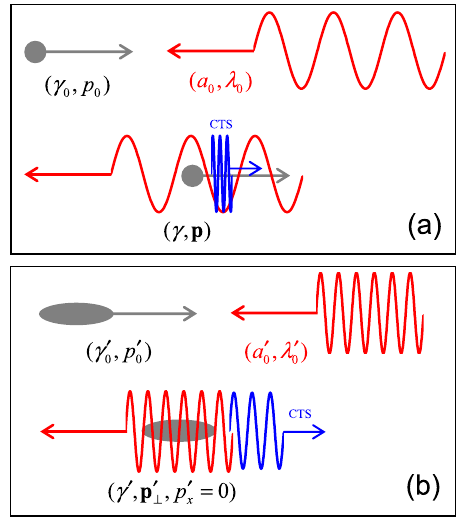
FIG. 3. Nonlinear CTS from RES in Fig. 2. (a) Temporal shape of CTS signal and theoretical calculation from Eq. (27). (b) Spectrum of CTS signal.